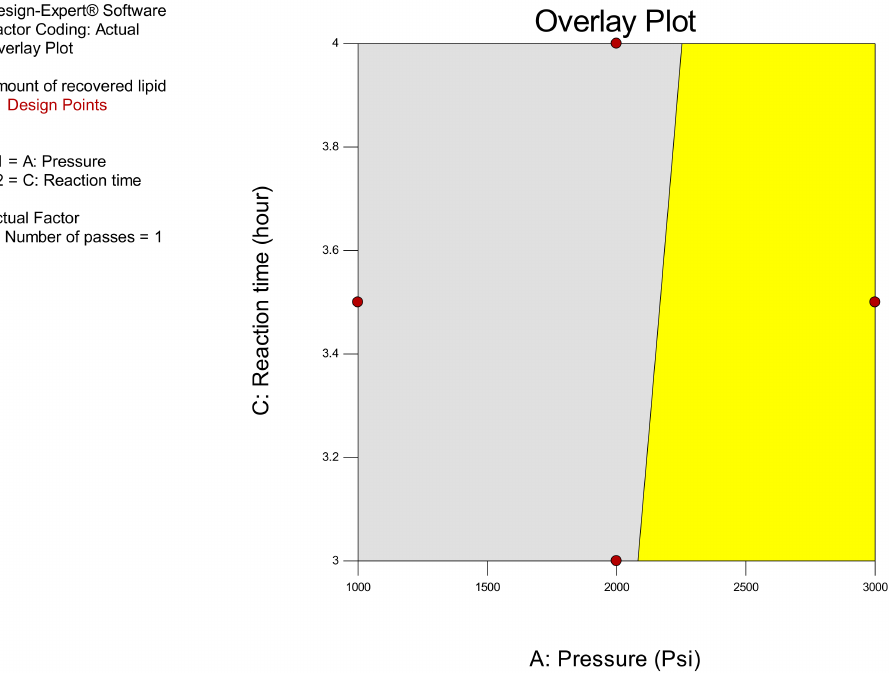
Figure 6. Graphical optimization for maximizing percentage of recovered lipid yield and minimizing the